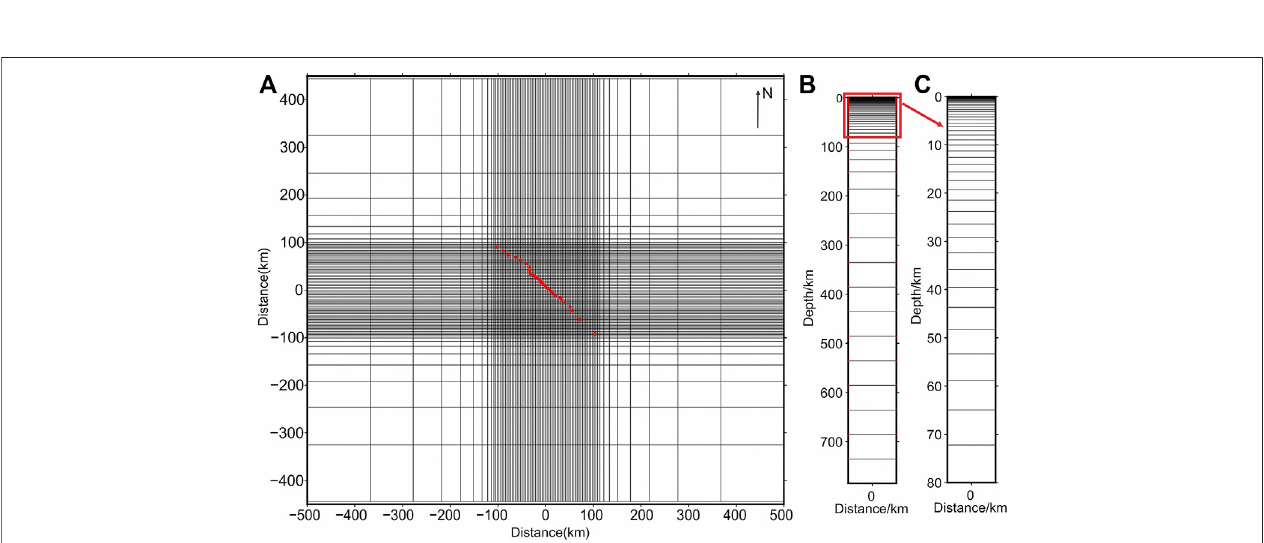
Frontiers in Earth Science |